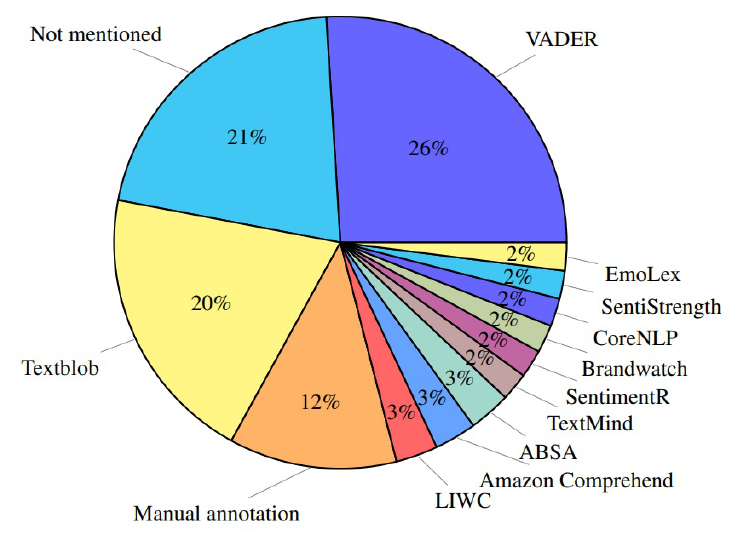
Figure 5. Distribution of sentiment annotation